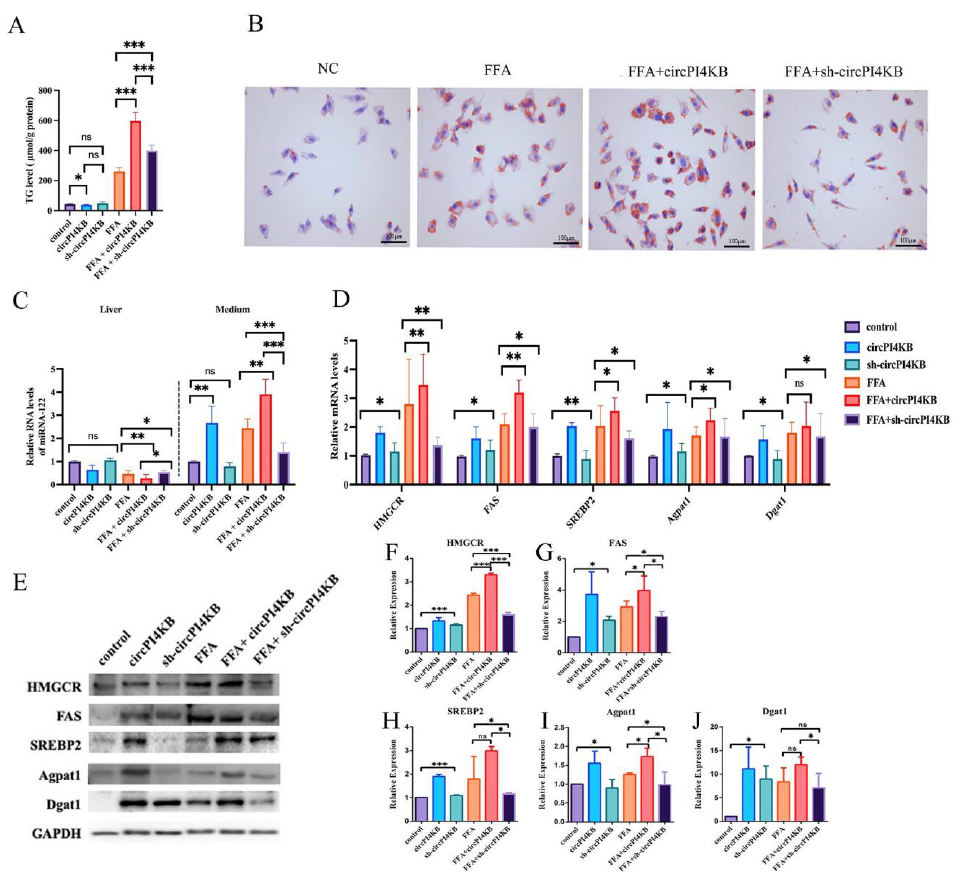
Figure 4. circPI4KB transported the protective miRNA-122 to extra-hepatocyte, resulting in lipid deposition in hepatocyte due to decreased intra-hepatocyte level of miRNA-122, ( n = 3). ( A ) En- zyme-linked immunosorbent assay was used to detect the level of TG in each group. ( B ) Oil red O staining validated the steatosis in L02 cells with FFA-induced and overexpressed (circPI4KB) or in- hibited plasmids (sh-circPI4KB) transfected, respectively (40×). ( C ) RT-qPCR showed the level of expression of intra- and extra-hepatocyte miRNA-122 after transfection with overexpressed (circPI4KB) or inhibited plasmids (sh-circPI4KB). ( D ) RT-qPCR analyses showed the modification of mRNA and protein levels of miRNA-122-downstream cholesterol synthesis ( HMGCR , FAS , SREBP2 ) and TG synthesis ( Agpat1 and Dgat1 ) after overexpressing or inhibiting circPI4KB. ( E – J ) Western blot ( E ) and gray value analysis ( F – J ) showed the protein levels of HMGCR, FAS, SREBP2, Agpat1, and Dgat1 after overexpressing or inhibiting circPI4KB. (* p < 0.05; ** p < 0.01; *** p < 0.001; ns: not significant). 3. Discussion In the present study, we confirmed that the decreasing level of miRNA-122 in the FFA-induced NAFLD cell model was caused by the excretion of miRNA-122, which sur- passed the synthesis. In addition, the level of circPI4KB and miRNA-122 were decreased in intra-hepatocytes but increased in the extra-hepatocyte in the FFA-induced NAFLD cell model, which was consistent with the results in the WD-induced NAFLD mouse model. Furthermore, the binding of circPI4KB and miRNA-122 was confirmed by both RNA pull- down and the luciferase reporter assay. We also showed that the overexpression and